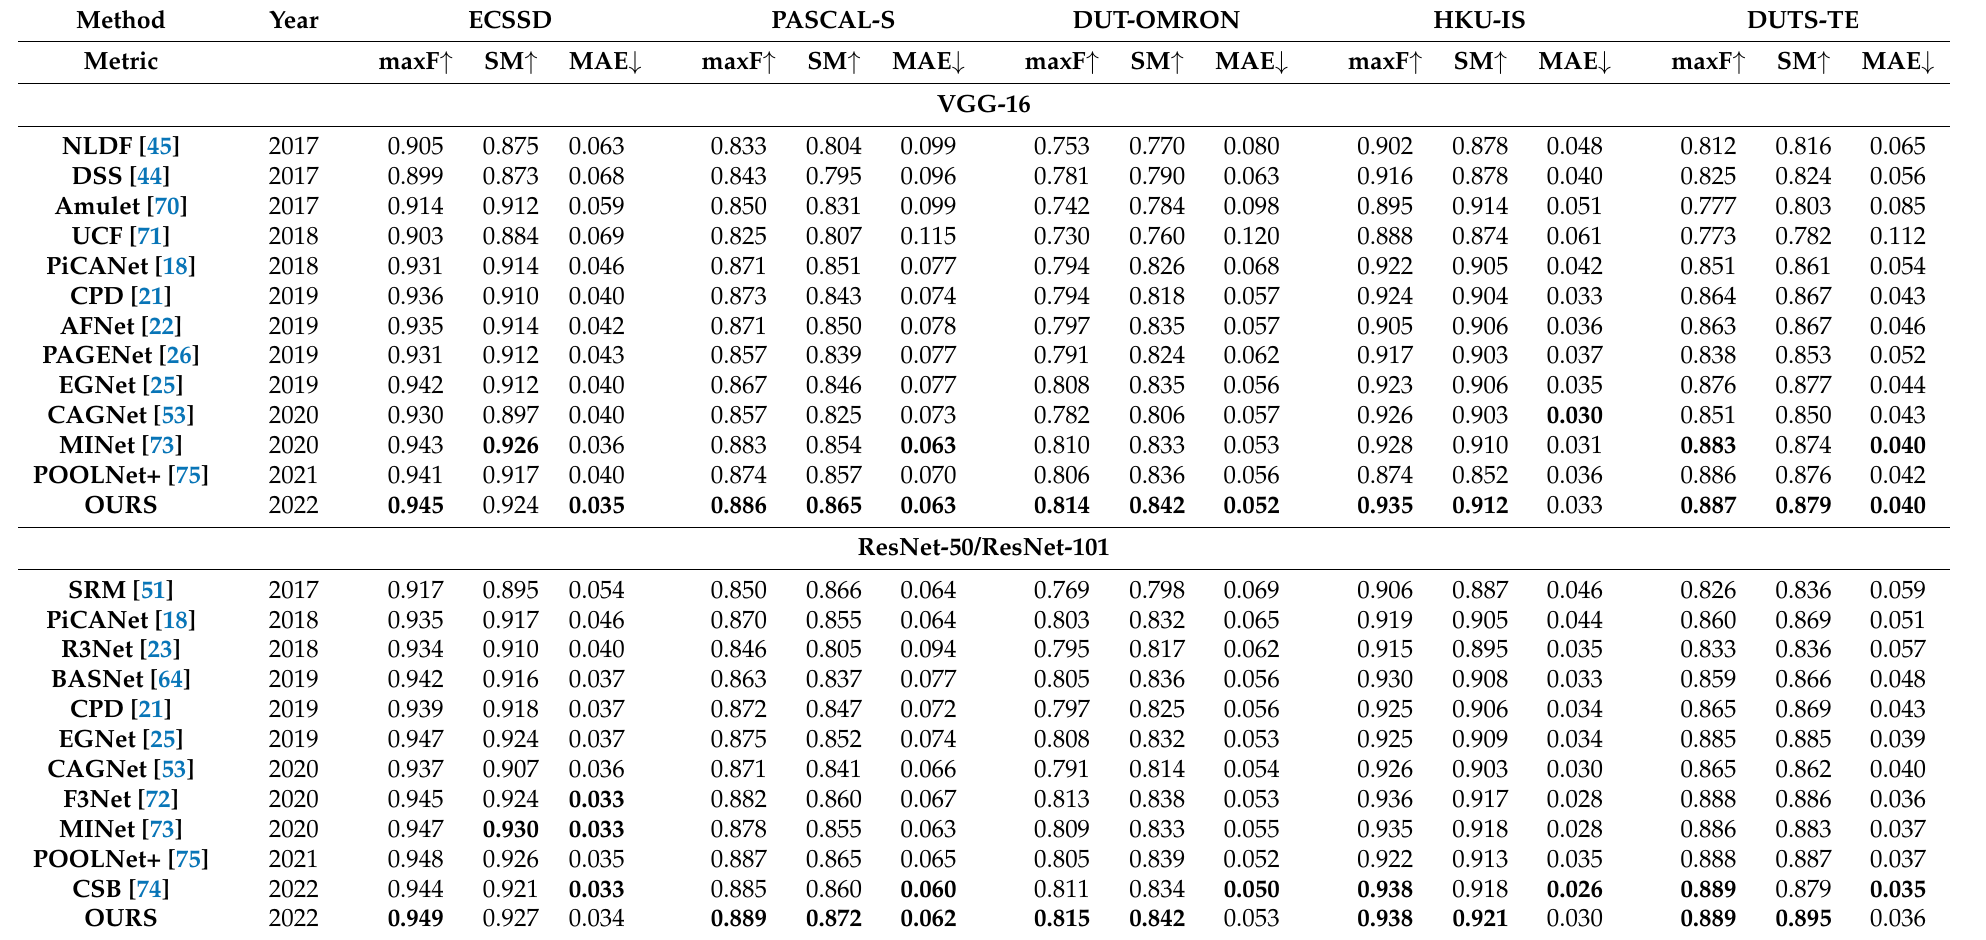
Table 2. Maximum F-measure (maxF), S-measure (SM), and mean absolute error (MAE) of the proposed model and 15 state-of-the-art algorithms. ↑ and ↓ indicate higher maxF and SM values and lower MAE values indicate better outcomes. Top scores are in